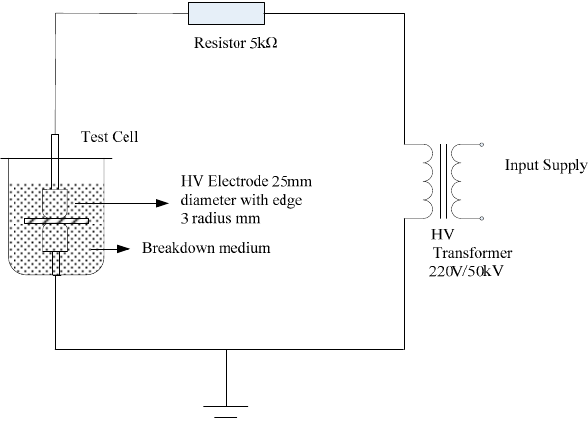
Figure 2. Experimental device for the AC breakdown test.